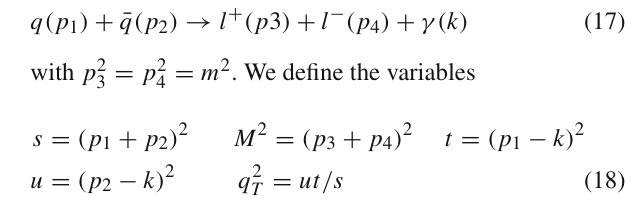
right) with the Sanc generator. The q T result is obtained by fixing r cut = 0 . 01% and with m l = m μ = 105 . 658369 MeV. For reference, also the LO result in showed (black